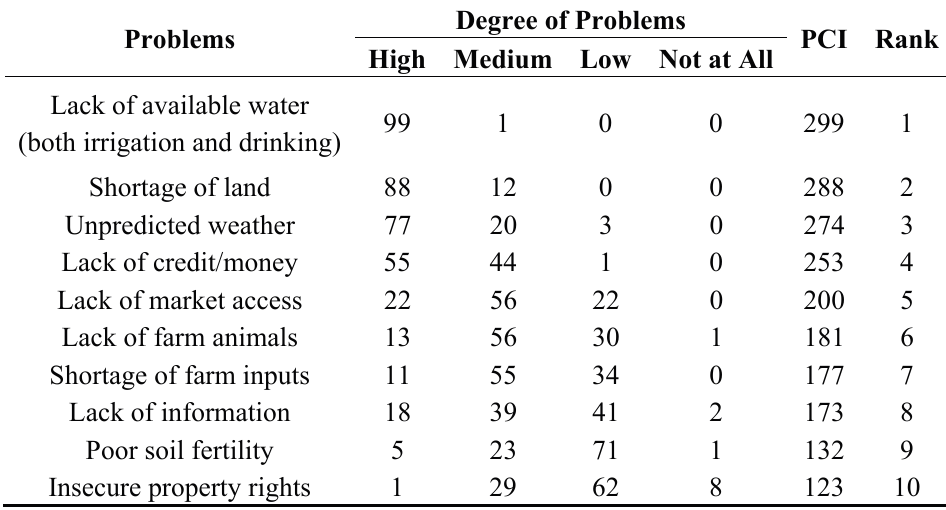
Table 6. Rank of the problems faced by the